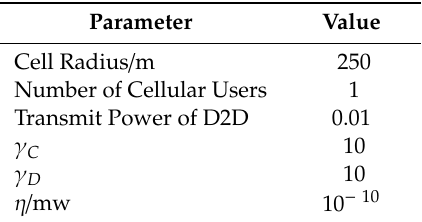
Table 2. Parameters setting of simulation.